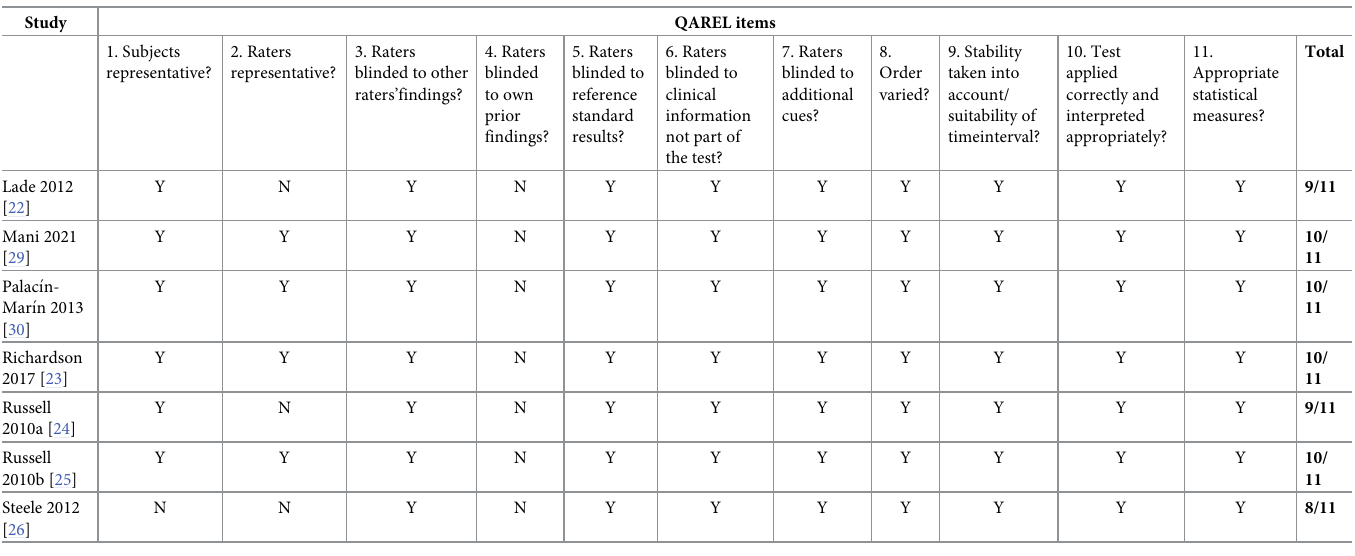
Table 4. QAREL risk of bias assessment of included studies reporting